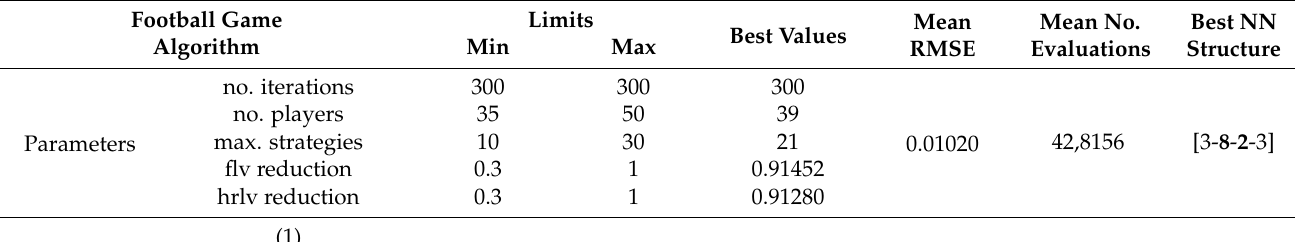
Table A1. The best results provided by the search procedure for the Football Game algorithm. Football Game